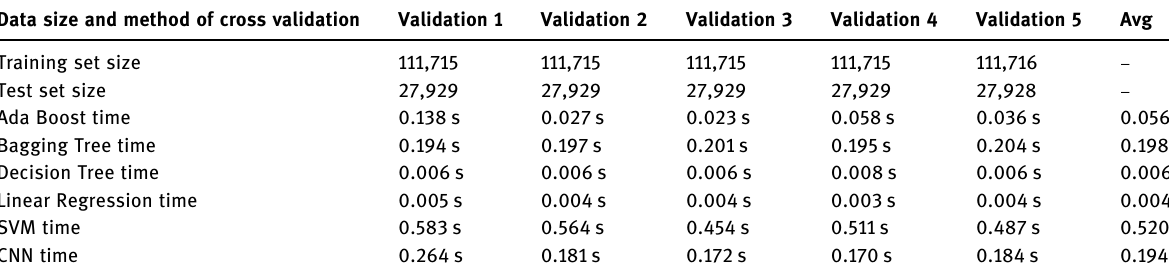
Table 4: Scale of training/test set and the time consumed by each